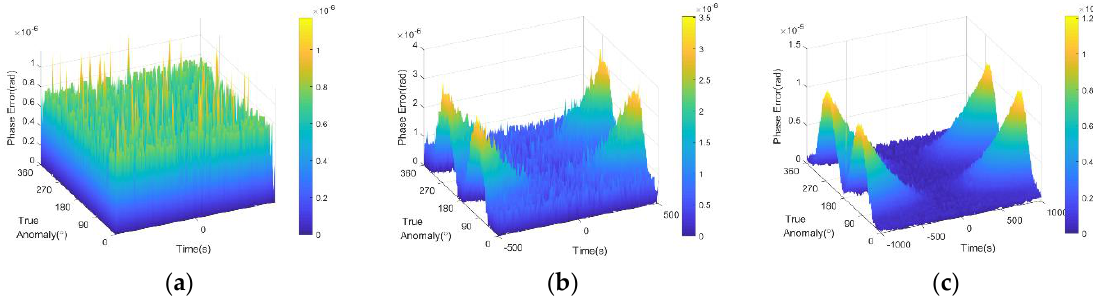
Figure 12. The fitting error of “stop-and-go” assumption compensation term through the iterative approximation for dif-